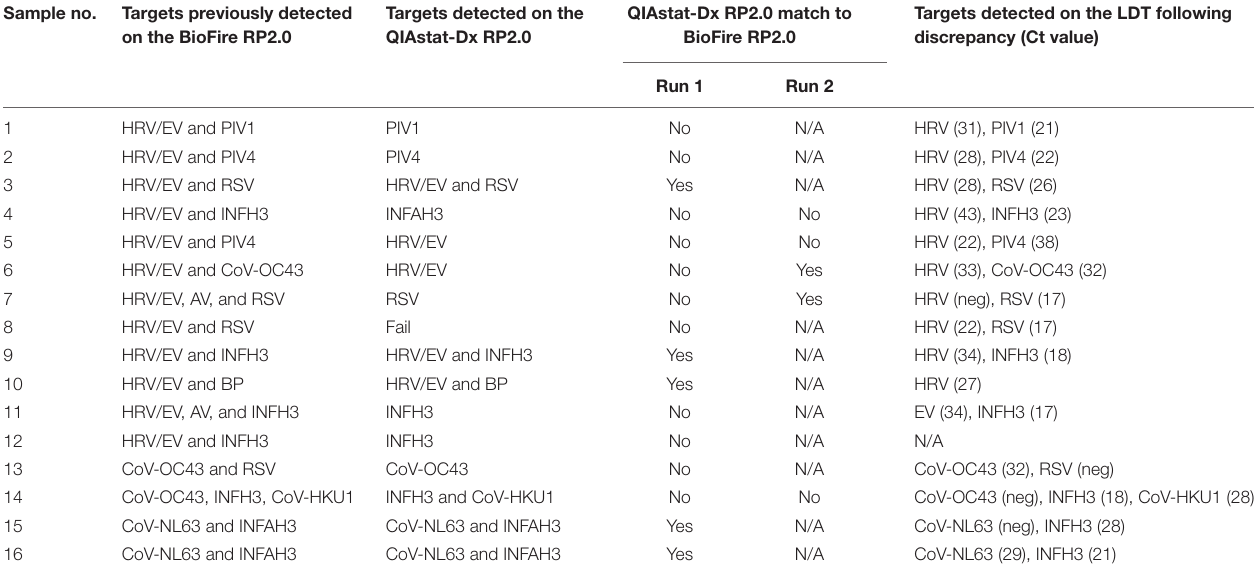
TABLE 5 | Performance of the QIAstat-Dx RP2.0 on multiple infections. Sample no. Targets previously detected on the BioFire